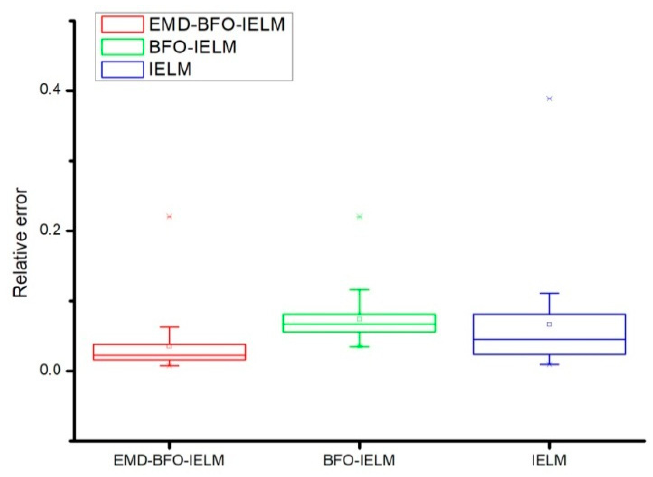
Figure 7. Relative error box plots for the three models.